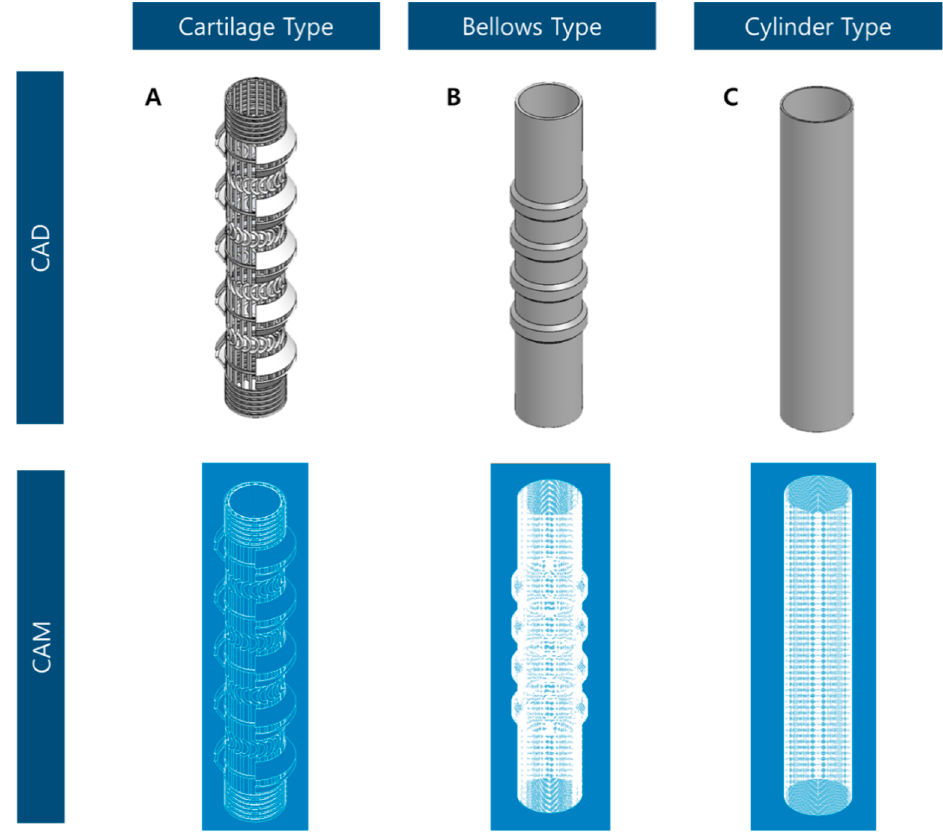
Figure 3. Design and 3D printing data for three types of trachea scaffolds: ( A ) cartilage type, ( B ) bellows type, and ( C ) cylinder